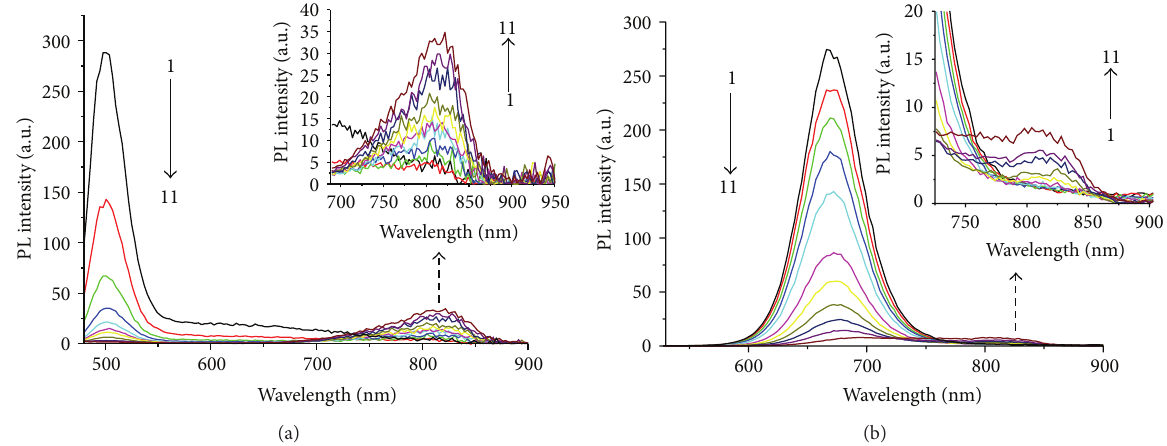
= 502 nm, (b) 𝜆 = 670 nm) with the concentration of Hg 2+ at 0.0, em em